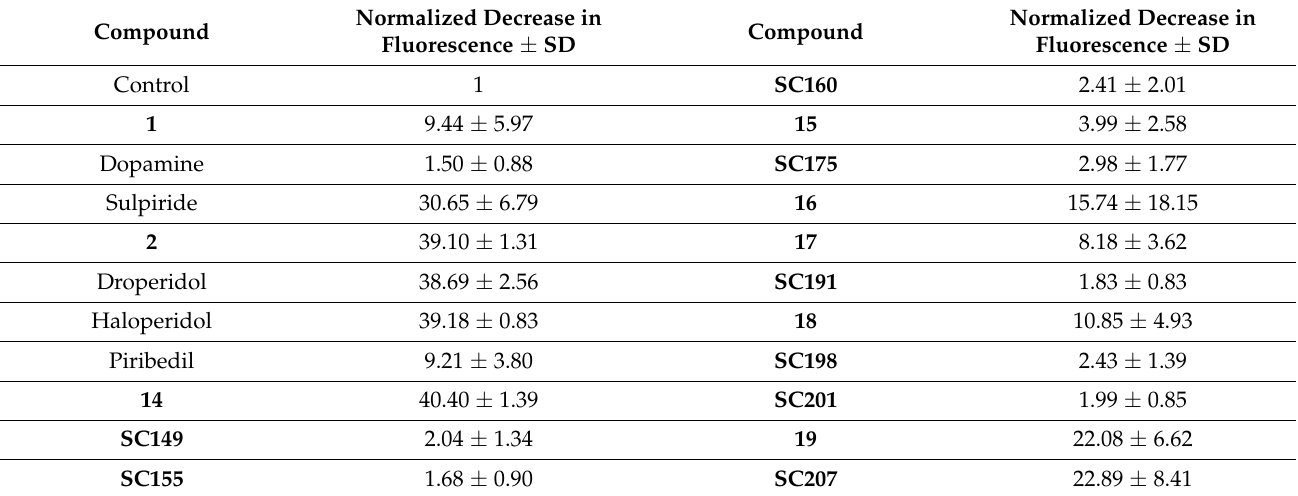
Table 3. Summary of the in vitro binding assessment of the compounds considered active. All measurements were conducted at a concentration of 10 µ M (n = 4). Fluorescence decrease was normalized to the control.